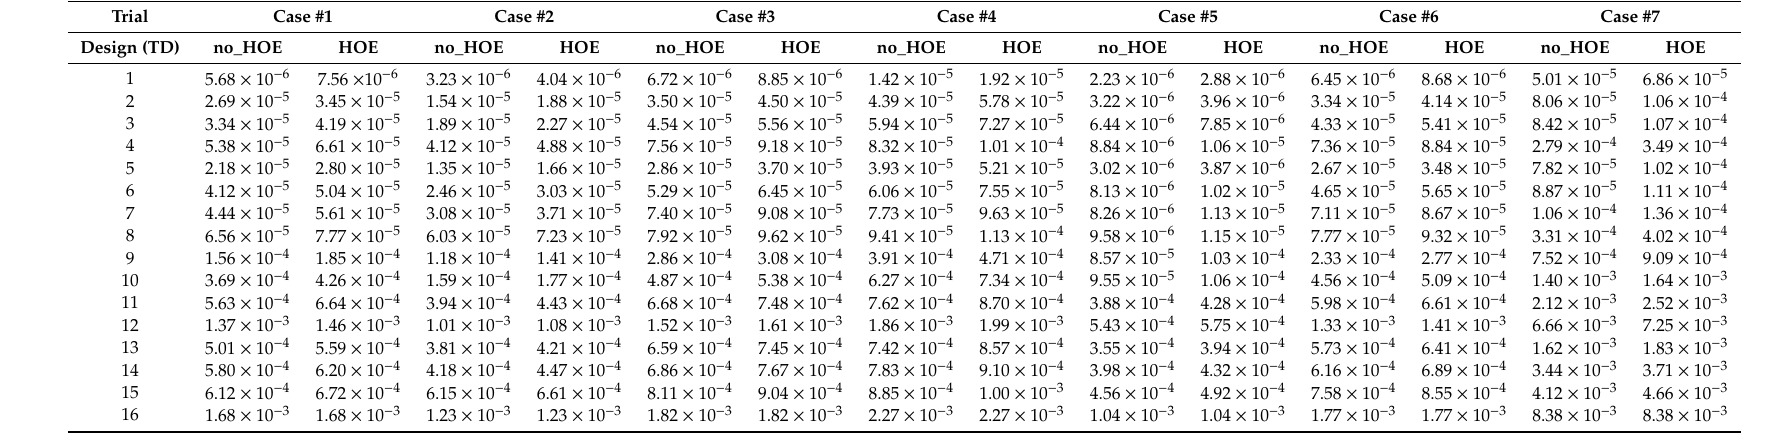
Table 10. ERL HOE results for case #1 to